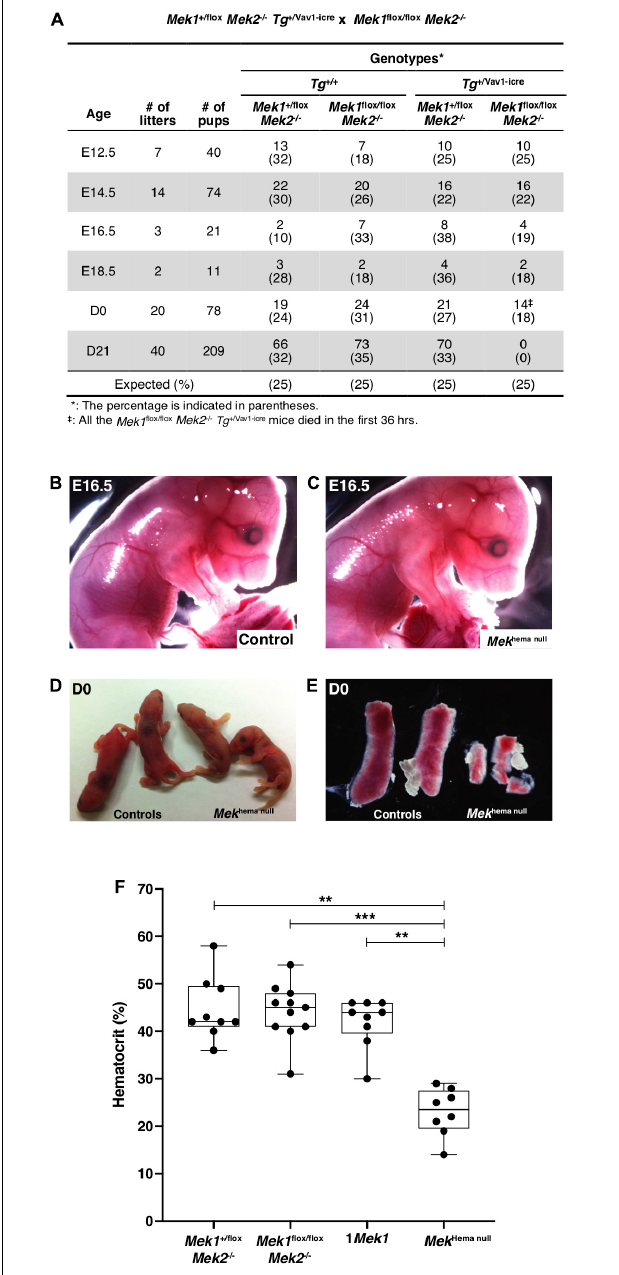
FIGURE 1 | Impact of the conditional Mek1 deletion with the Vav1-icre in the Mek2 − / − background. (A) Ratios of embryos and mice genotypes at different embryonic and adult stages obtained from matings between Mek1 + / flox Mek2 − / − Tg + / Vav 1 − iCre male with Mek1 flox / flox Mek 2 − / − female. (B–D) Gross morphology of E16.5 (B,C) and D0 (D) control and Mek hema null animals. Normal vascularization and blood circulation were seen in controls and Mek hema null embryos at E16.5. (E) Macroscopic views showing the hypoplastic Mek hema null spleen phenotype at D0 compared with spleen from littermate controls. (F) Hematocrit at birth. No sign of cyanosis was detected at birth in Mek hema null embryos, but they died in the first 36 h with a severe anemia. The results are presented as whiskers-and-boxes graph, and each dot represents an individual mouse. ANOVA with Kruskal–Wallis multiple-comparisons test was performed. ** P < 0.01, *** P <